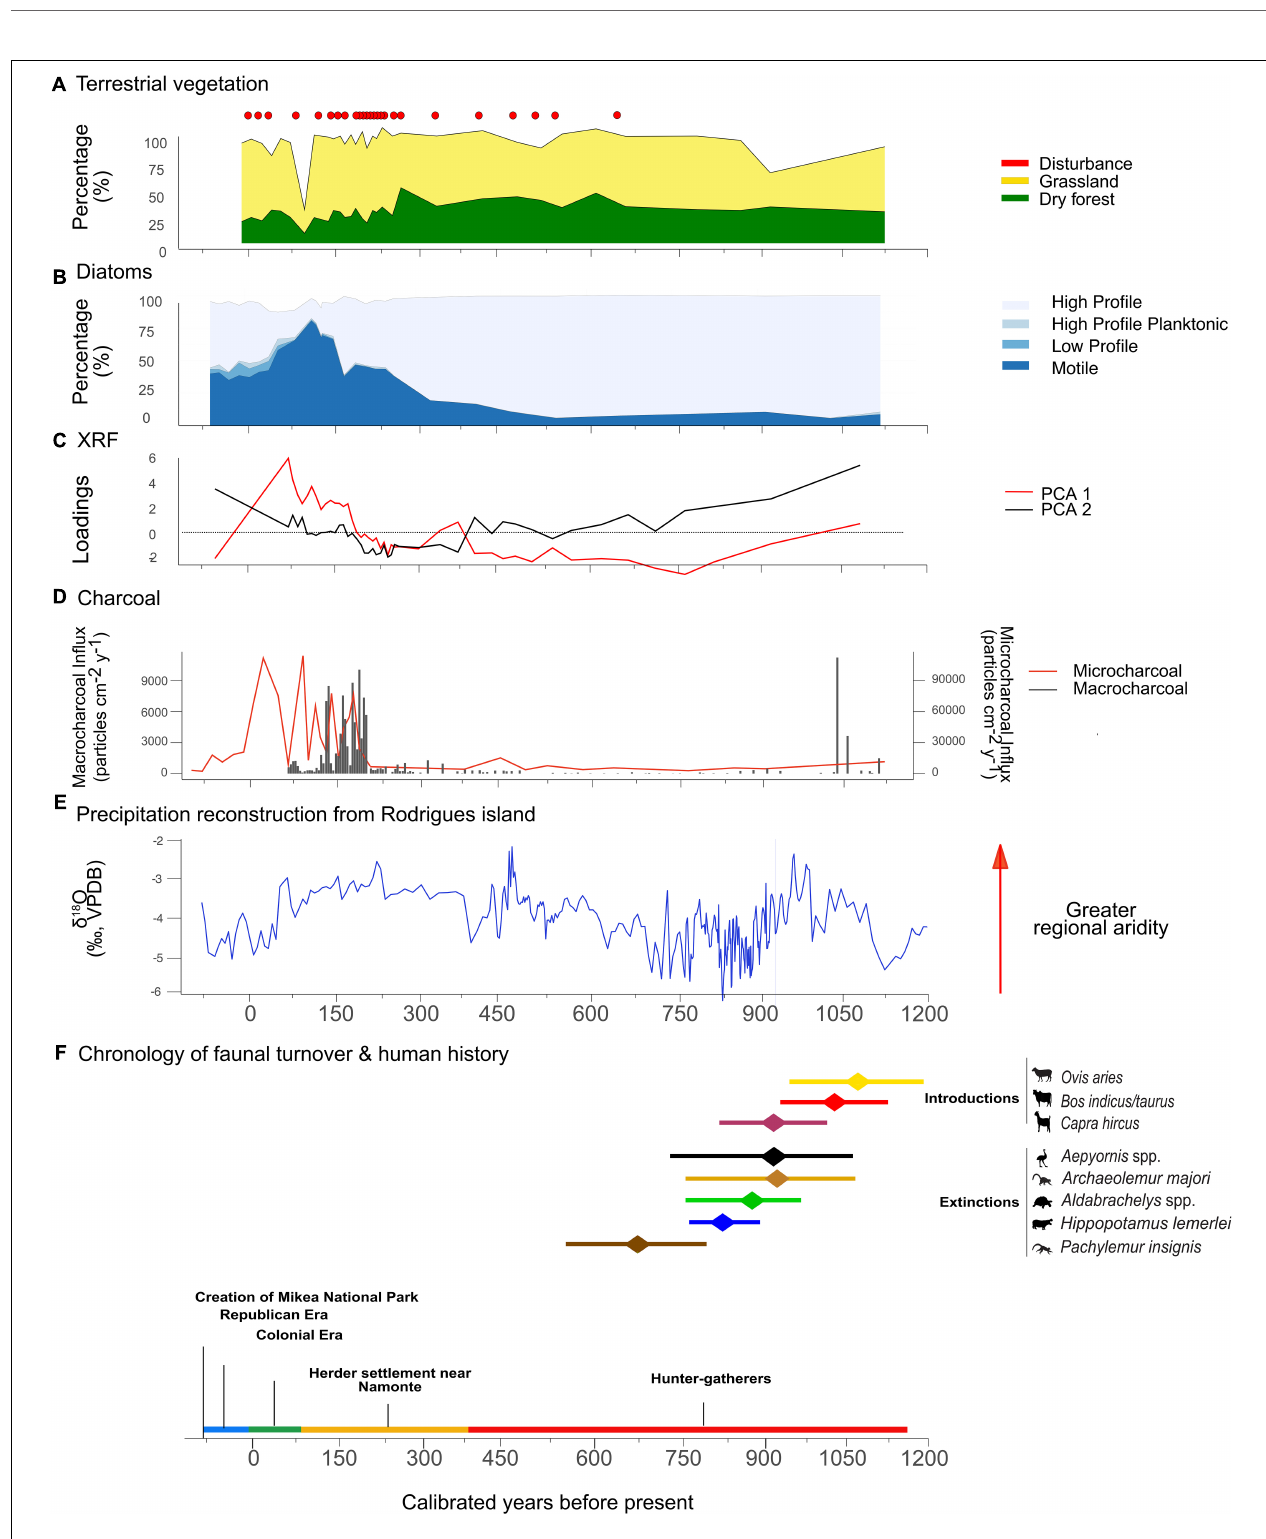
FIGURE 8 | Abbreviated paleoecological diagram for the last ∼ 1,145 years, inferred from the Namonte core, southwest Madagascar. (A) Pollen percentages of disturbance taxa, grasslands, and dry forest, (B) percentages of diatom guilds, (C) PCA1 and PCA2 of XRF analysis, (D) Influx of macrocharcoal and microcharcoal particles, (E) Precipitation reconstruction from the Rodrigues Island, Indian Ocean, speleothem δ 18 O record (Li et al., 2020), and (F) chronology of faunal turnover (based on classical confidence intervals from Hixon et al., 2021a) and approximate human history based on archaeological, written and oral records (Douglass et al.,